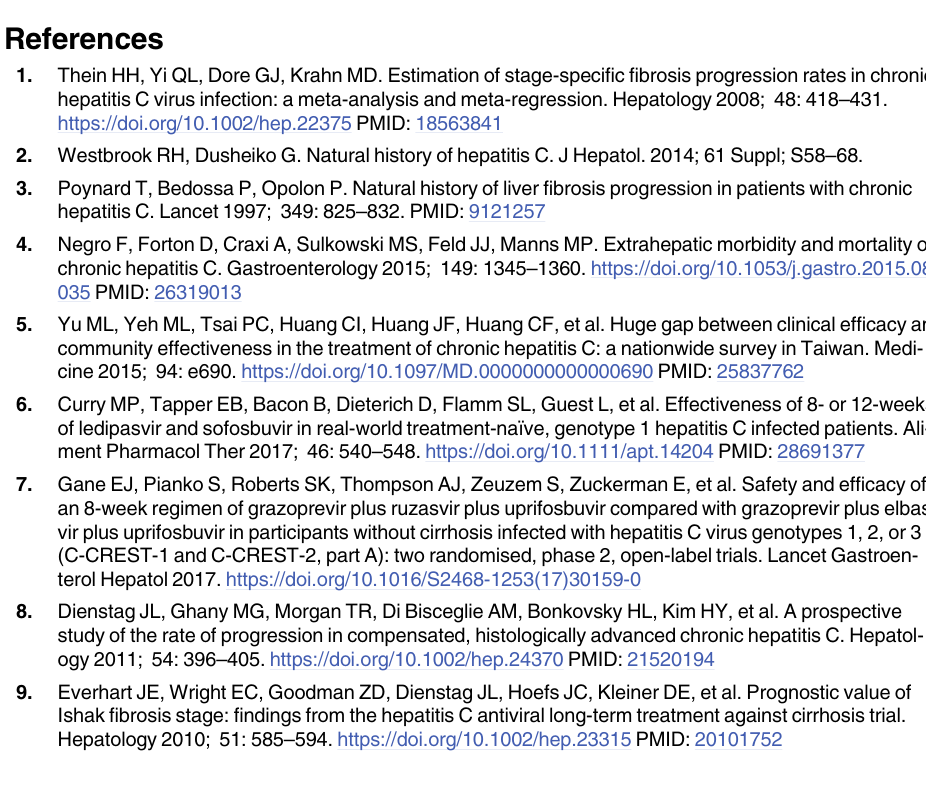
S2 Fig. The scatter plot of TE.